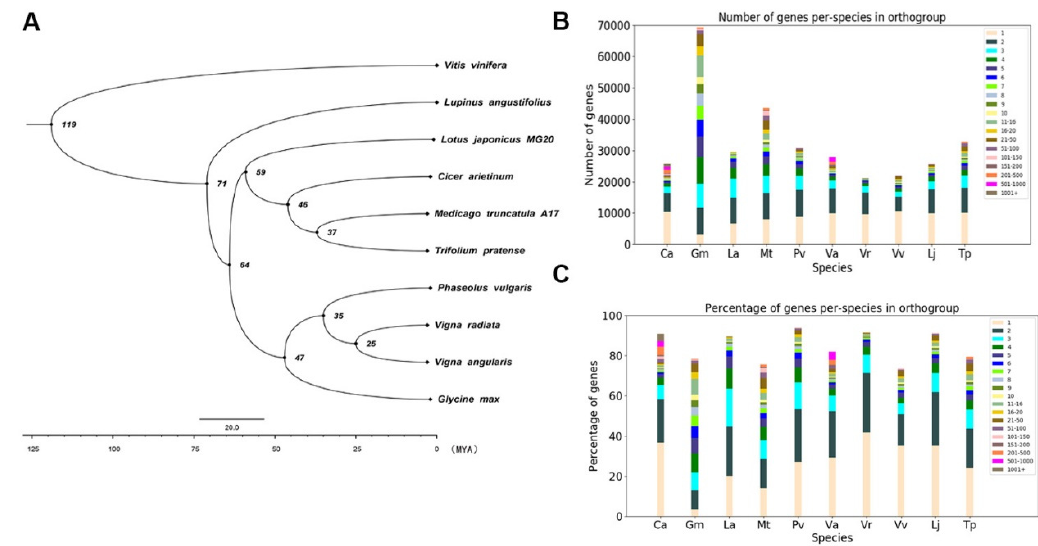
Figure4. Speciesphylogenetictreesandstatisticsoforthologousgenesamongspecies. ( A )genome-wide Figure 4. Species phylogenetic trees and statistics of orthologous genes among species. A, genome- phylogenetictreeof ninelegumespecies, showing theirphylogeneticrelationshipand timeofdivergence. wide phylogenetic tree of nine legume species, showing their phylogenetic relationship and time of ( B ) Statistical analysis of orthologous genes between species. Di ff erent colors indicate the number of divergence. B, Statistical analysis of orthologous genes between species. Different colors indicate the di ff erent orthologous genes, and the histogram represents the total number of di ff erent orthologous number of different orthologous genes, and the histogram represents the total number of different genes of a single species. ( C ) comparison of the proportions of di ff erent orthologous genes in the orthologous genes of a single species. C, comparison of the proportions of different orthologous genes genomes of a single in the genomes of a single species.